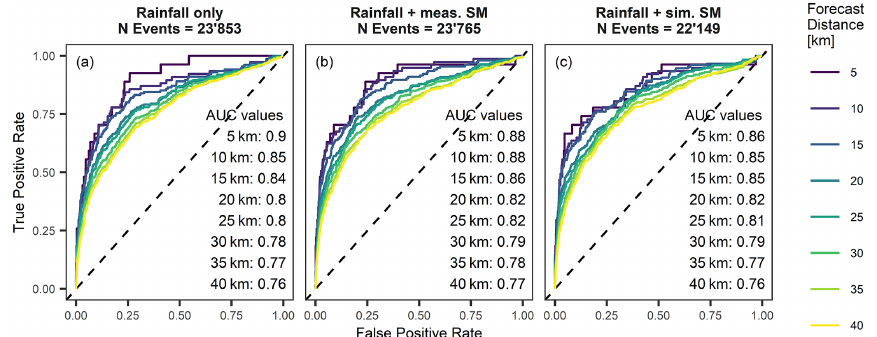
Figure 12. ROC curves and AUC values of model fits (a) based on normalized rainfall information only, (b) based on normalized rainfall and measured antecedent saturation and (c) based on normalized rainfall and simulated antecedent saturation for all 35 monitoring sites and the period of 2008 to